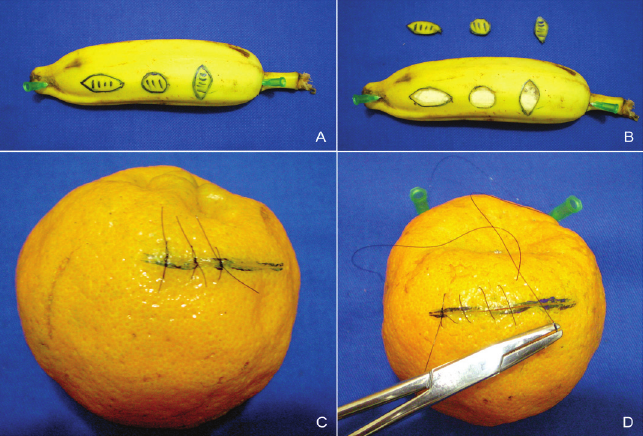
FIGURE 2 – Organic model for the learning on different techniques of incisions and sutures. ( A-B ) Elliptic and circular pattern. ( C ) Single interrupted suture and ( D ) running simple suture. Besides the correct way to handle instruments (scalpel, tweezers and needle) are important to teaching about the placement of the scalpel in relation to “skin” (relationship of the angles), the proper way to perform the incision (e.g., no movements of “aliasing” and no movement sideways), and carrying out the sutures (e.g., spacing of stitches and coaptation of the “edges”).